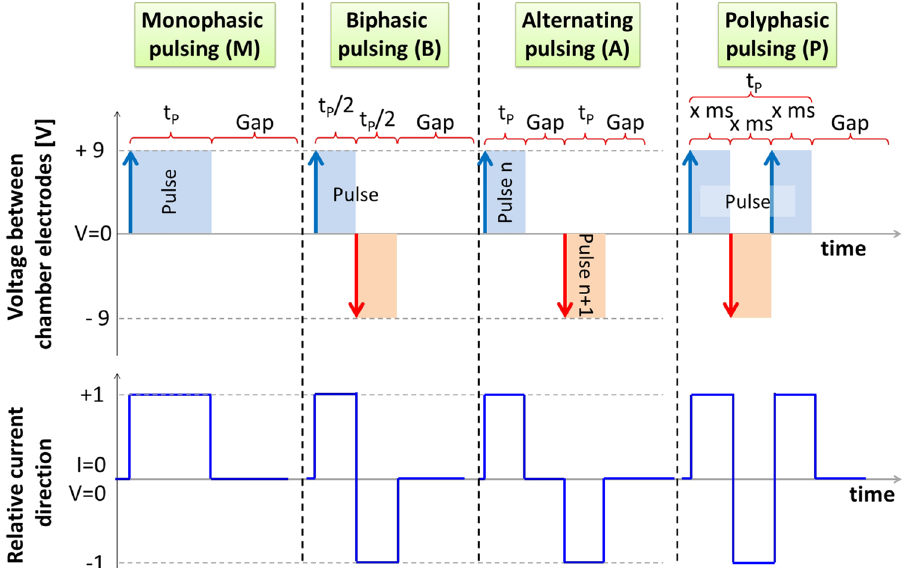
Figure 1. Pulse types of the MyoPulser-device. The upper part of this figures displays the four different pulse-types available by the MyoPulser: Monophasic (M), Biphasic (B), Alternating (A) and polyphasic (P). Polarization or its inversion is indicated by vertical arrows. Pulse length (t p ) is depicted as color-filled area, gap length (Gap) without electrical stimulation are just white. Polyphasic pulsing is characterized by a rapid change of polarity, adjustable in the range of milliseconds (“x ms”). The part below depicts the according relative direction of the electric current, following the potentials’ direction between the electrodes of the sample chamber as shown